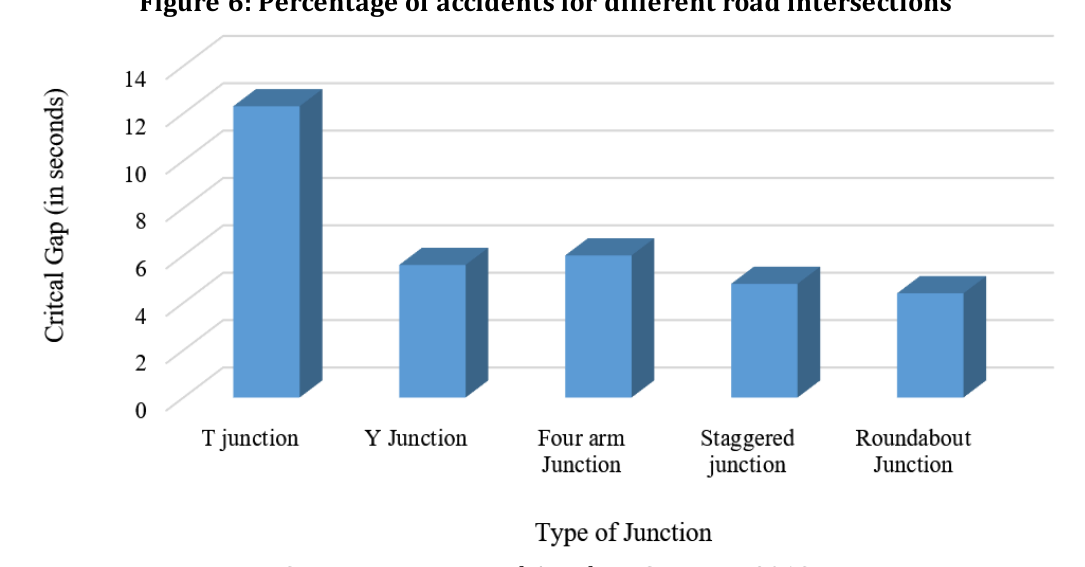
Source: MoRTH Road Accident Statistics